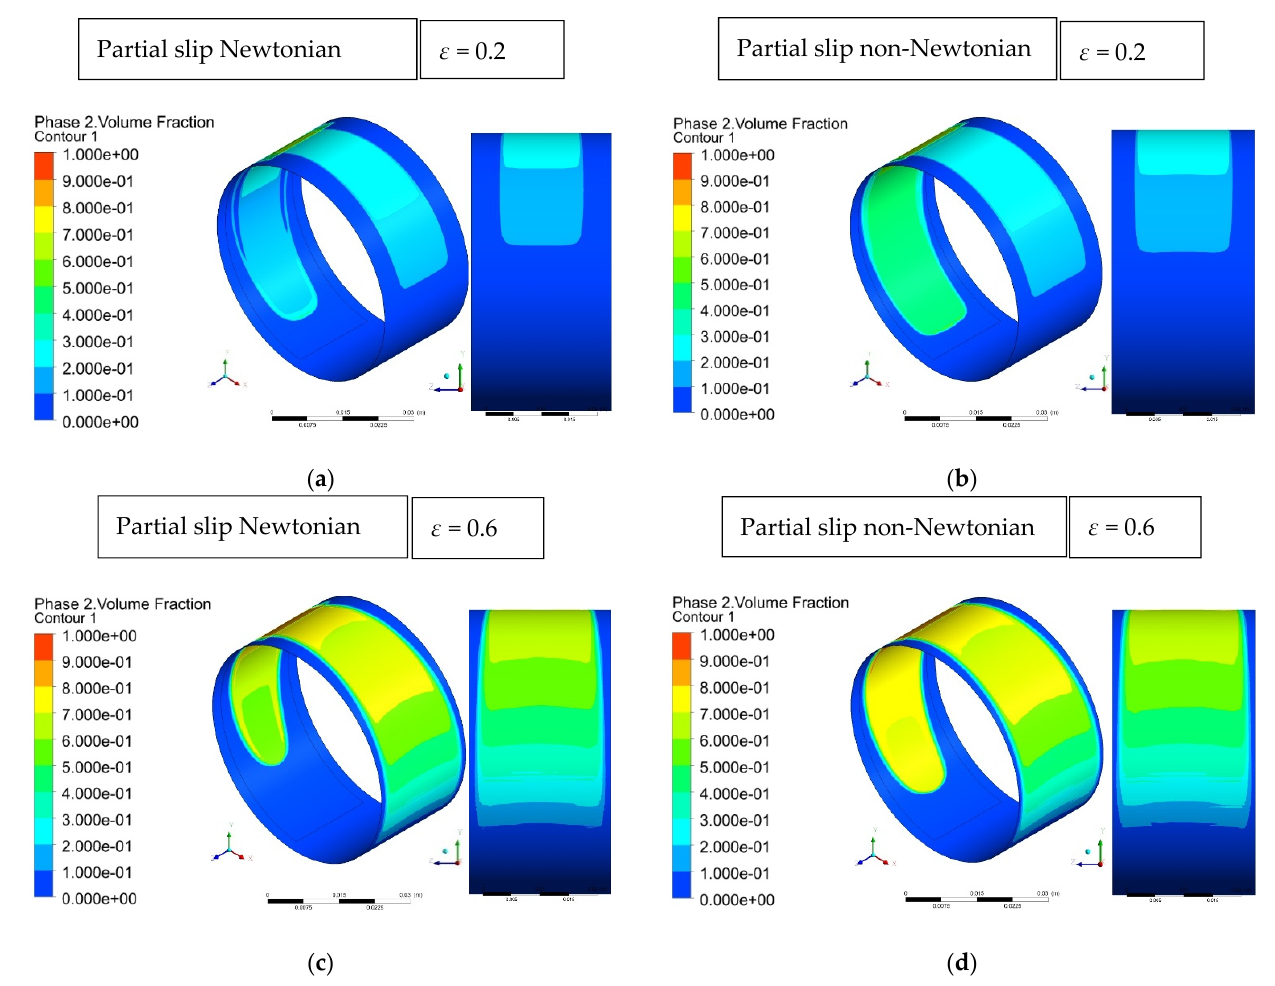
Figure 8. Vapor volume fraction for partial slip bearing for case: ( a ) Newtonian, ε = 0.2; ( b ) non- Newtonian, ε = 0.2; ( c ) Newtonian, ε = 0.6; ( d ) non-Newtonian, ε = 0.6.